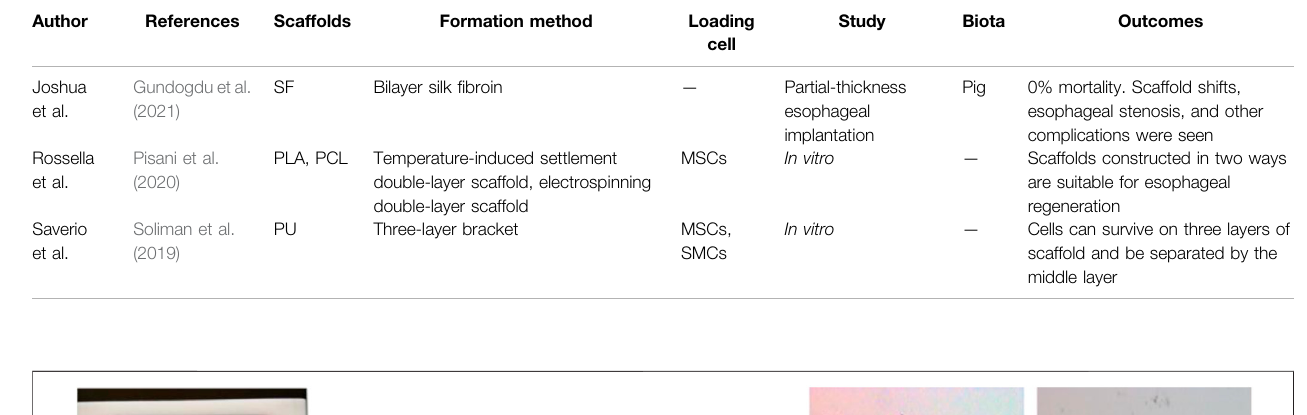
TABLE 3 | Classi fi cation according to the construction of bionic scaffolds.